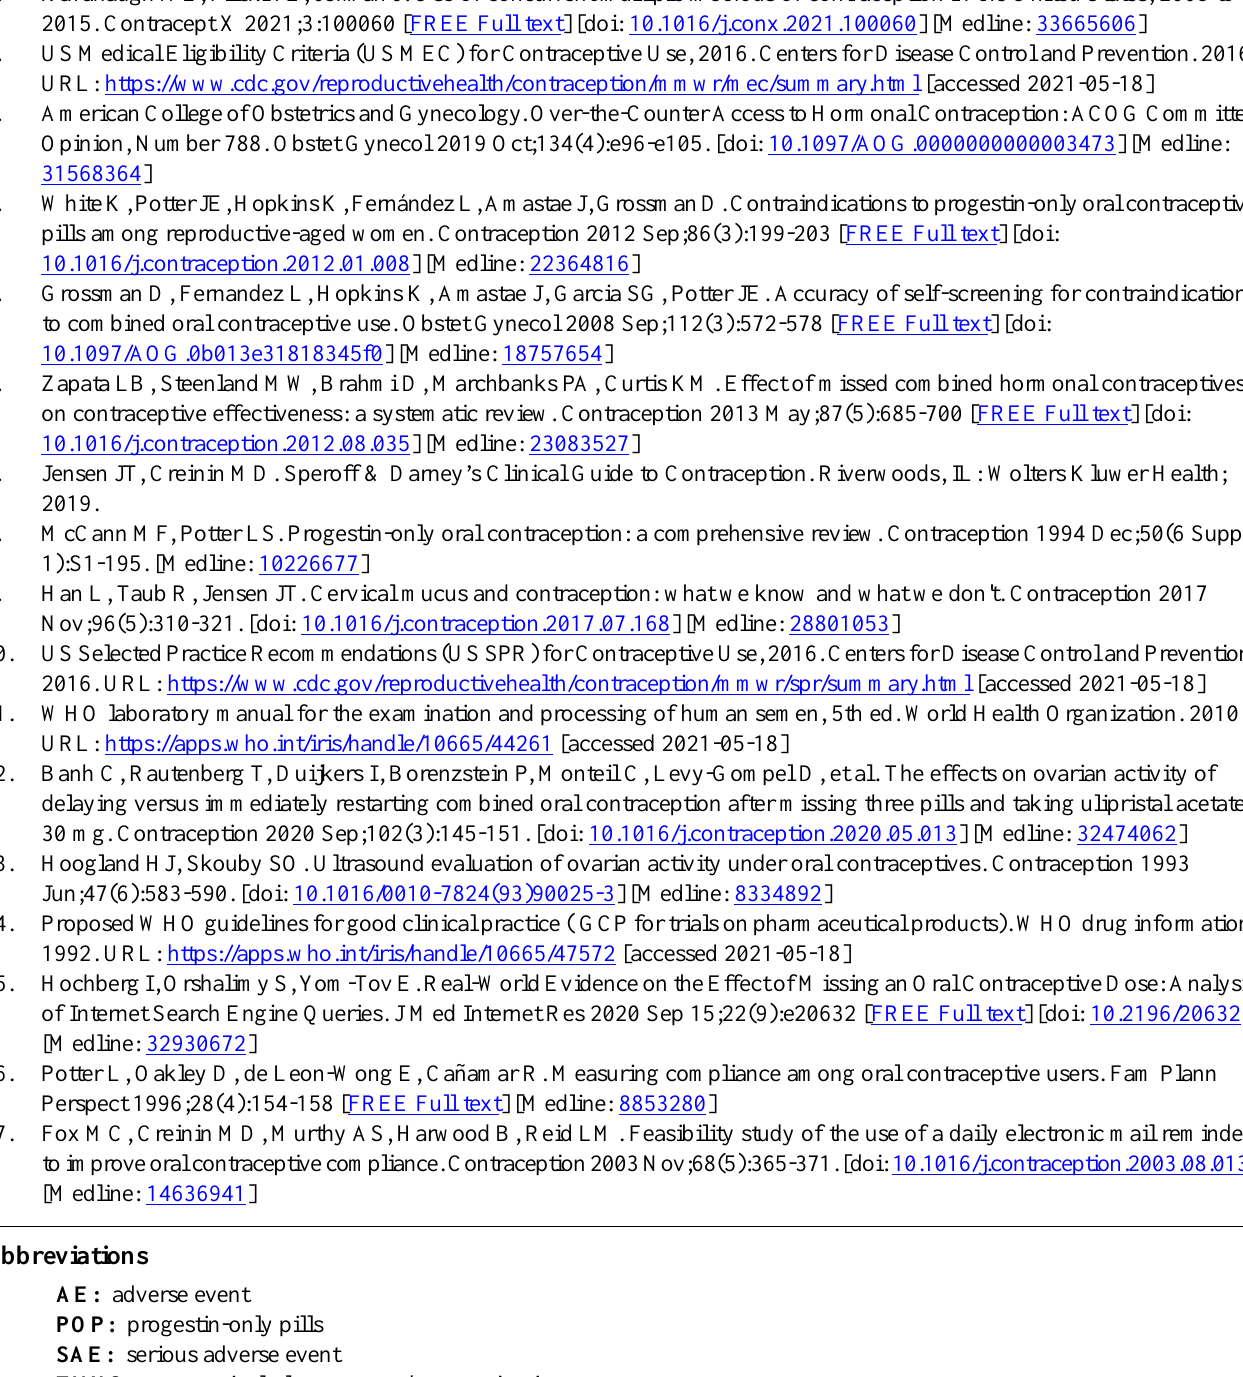
POP: progestin-only pills SAE: serious adverse